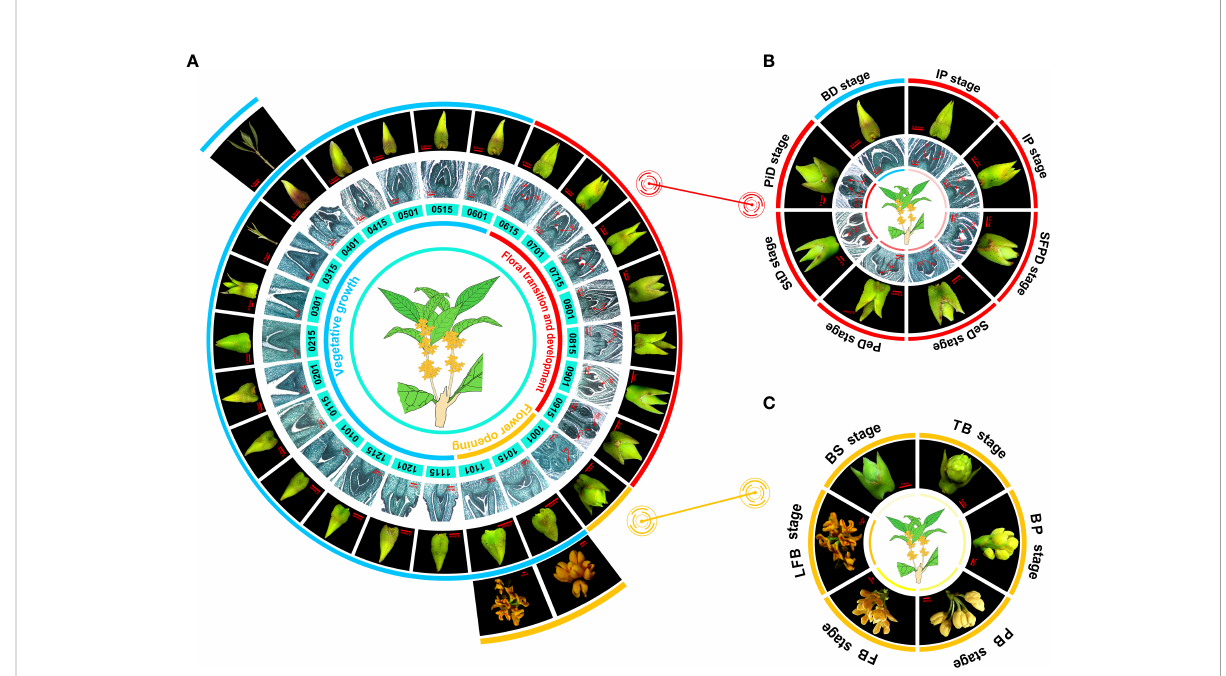
FIGURE 1 The fl owering phenology shifts in O. fragrans ‘ Yanhonggui ’ for 1 year. (A) The phenotypic changes of ‘ Yanhonggui ’ in 1 year. Different colored lines represent different stages of development: blue represents vegetative growth; red means fl oral transition and development; orange represents fl ower opening. The numbers below the picture represent dates. For example, 0115 is January 15. (B) The fl oral transition and development process. BD: bud pre-differentiation stage; IP: in fl orescence primordium differentiation stage; SFPD: small fl oret primordium differentiation stage; SeD: sepal differentiation stage; PeD: petal differentiation stage; StD: stamen differentiation stage; PiD: pistil differentiation stage. Due to the obvious change in phenotype, the IP stage was repeated. (C) The fl ower opening process. BS, ball-shaped stage; TB, top bracts stage; BP, bud pedicel stage; PB, primary blooming stage; FB, full blooming stage; LFB, late full blooming stage. Br, Bract; Ip, in fl orescence; FP, fl oret primordium; Se, sepa primordium; Pe, petal primordium; St, stamen primordium; An, anther; Car,